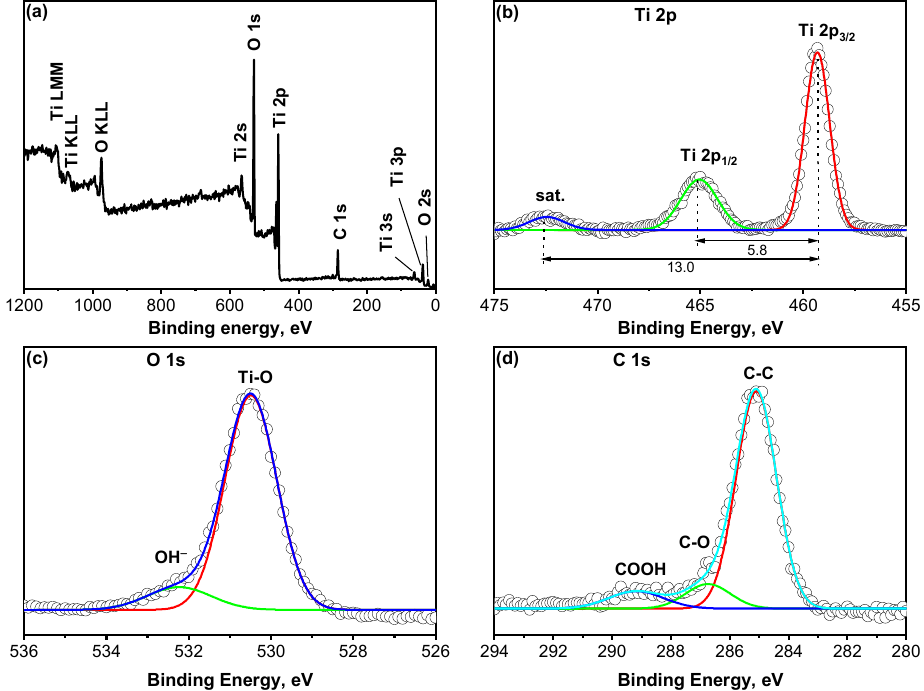
Figure 2. XPS spectra of the rutile nanoparticles. ( a ) XPS survey spectrum; ( b – d ) are spectra from Ti 2p, O 1s, and C 1s core levels.